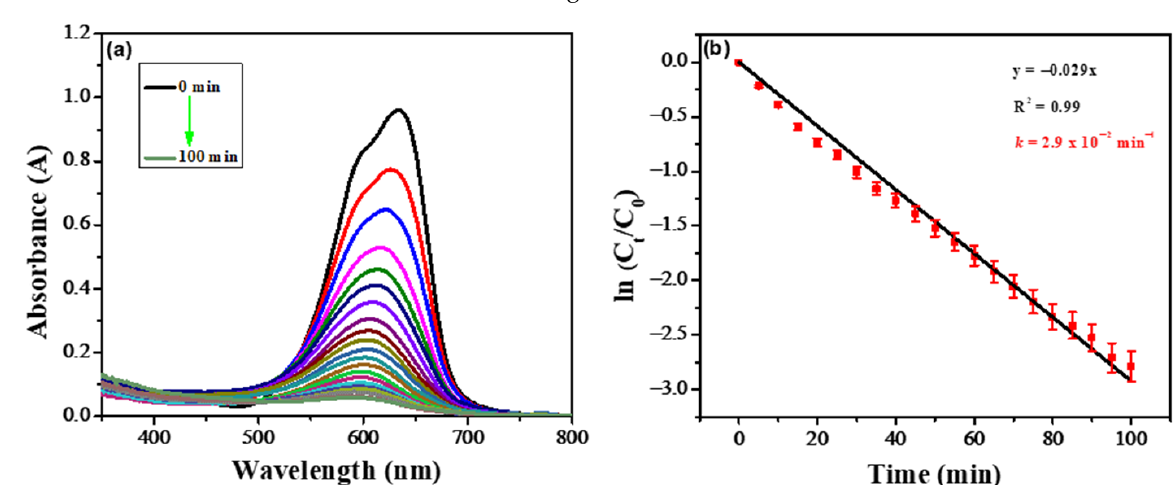
Figure 9. ( a ) UV-Vis spectra of the photocatalytic degradation of NBS at different time intervals. ( b ) The photocatalytic degradation kinetics of NBS using UV-visible spectroscopic data.